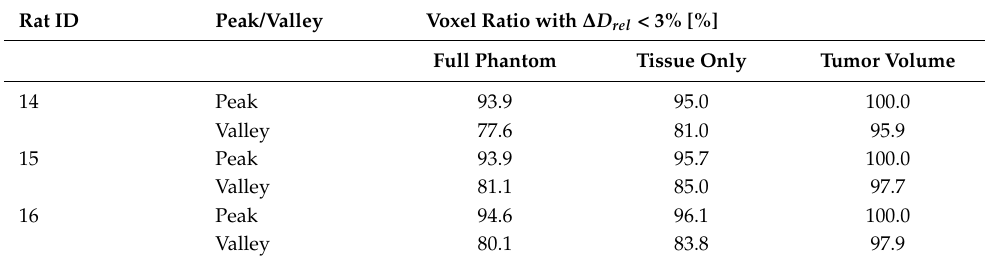
Figure 11. ( a ) Relative dose difference ( ∆ D rel ) between ML and MC models for test rat number 14 in the peak and valley regions. The tumor volume in the shown slice is indicated with a white overlay: ( b ) depth–peak dose curves; ( c ) depth–valley dose curve at the center of the prediction volume. Doses are normalized to the valley doses at the center of the brain. Table 2. Fraction of voxels with a relative deviation of dose ∆ D rel between ML prediction and low-noise MC simulation of less than 3% in the peak and valley regions, shown for the full phantom, only tissue parts of the phantom (the bone voxels were considered) and the treated tumor volumes. Rat ID Peak/Valley Voxel Ratio with ∆ D rel < 3%